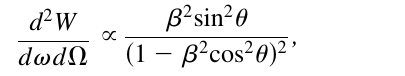
FIG. 8. (Color) Spatial distribution of the electromagnetic field energy behind the foil, 30 fs after the first particles emerge from the foil. The contours show the peak of the emitted radiation, comparing it to the expected peak emission (dashed). The black dots represent the particles emitted from the The contour lines show the peak of the radiated energy propagating at an angle of about (cid:11) (cid:1) 51 (cid:11) . This angle corresponds well to the peak emission angle expected for a single particle with (cid:10) (cid:3) 0 : 78 , using Eq. (21).